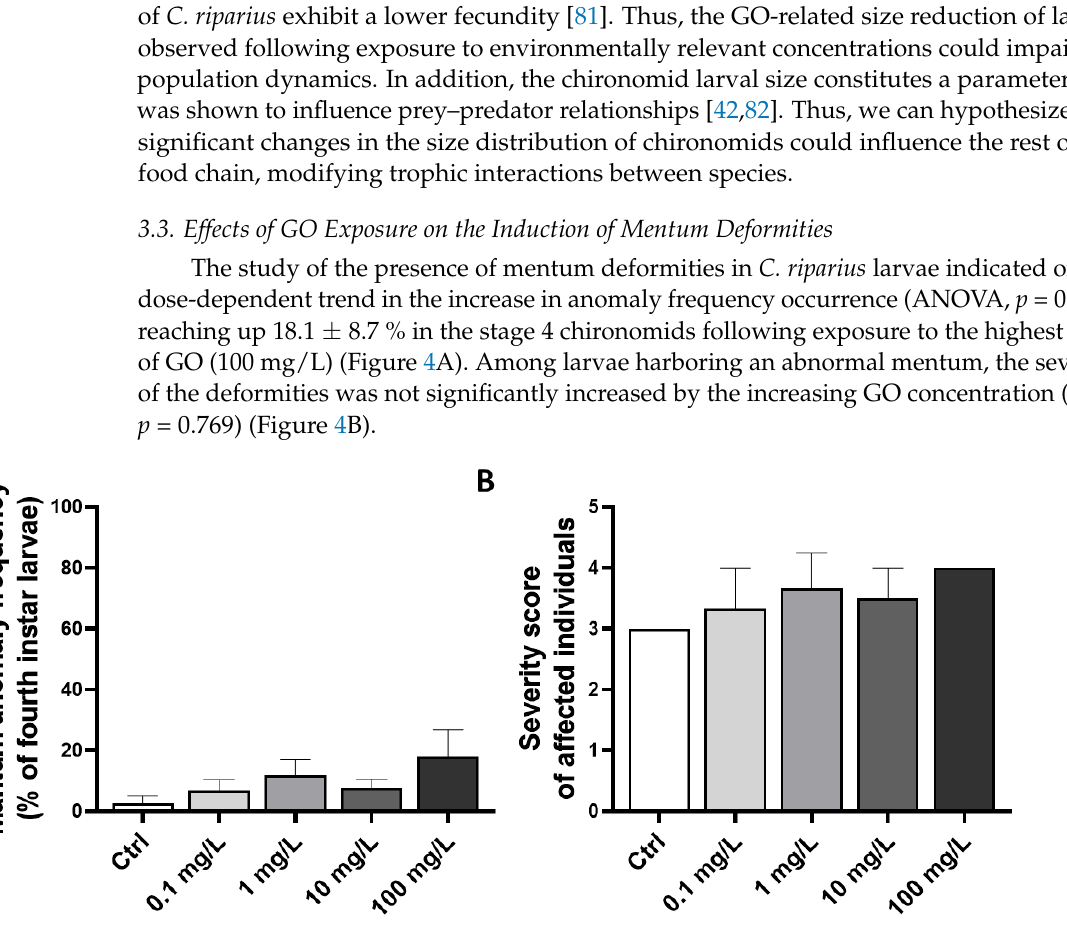
Figure 4. Effects of exposure to an increasing GO concentration on the frequency of mentum deformi- ties occurrence in fourth instar C. riparius larvae ( A ) and severity score of affected larvae from each experimental condition ( B ). Statistical analysis was conducted using ANOVA for anomaly frequency and Kruskal–Wallis for severity score, p > 0.05.